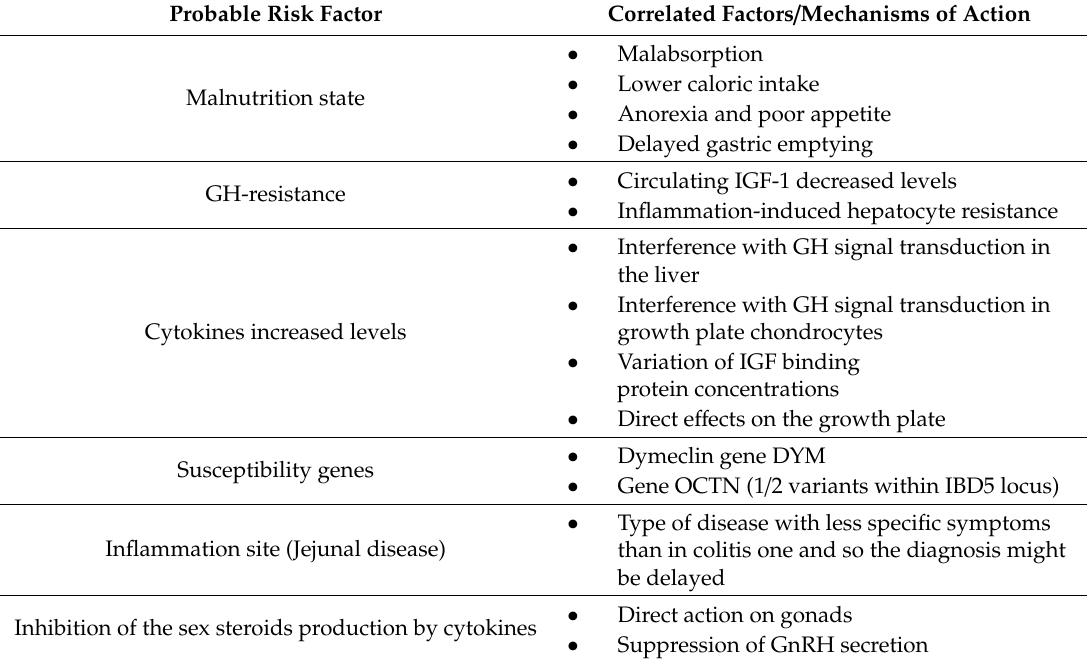
Table 1. Possible risk factors for growth failure and delayed puberty in inflammatory bowel diseases